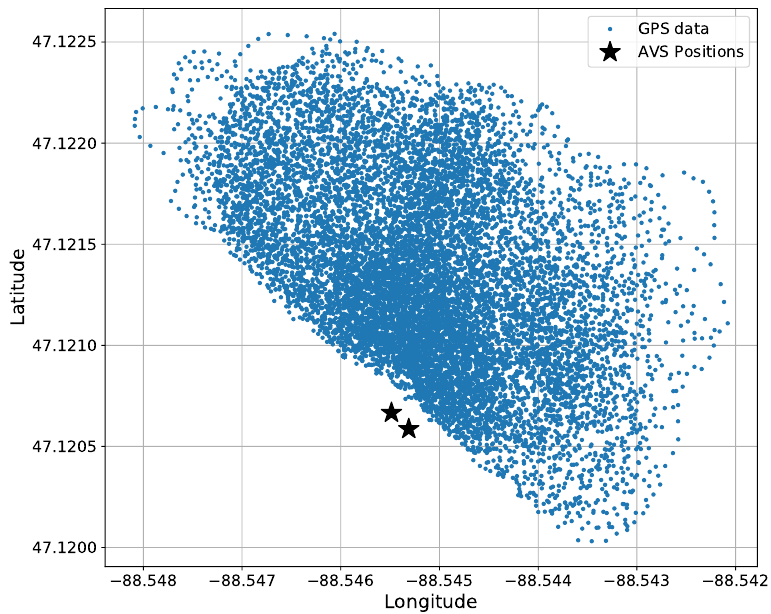
Figure 8. Bird’s eye view of the total amount of GPS data in all datasets before 20-times interpolated. GPS data are accumulated from 8 experiments. The two AVS positions are shown for a